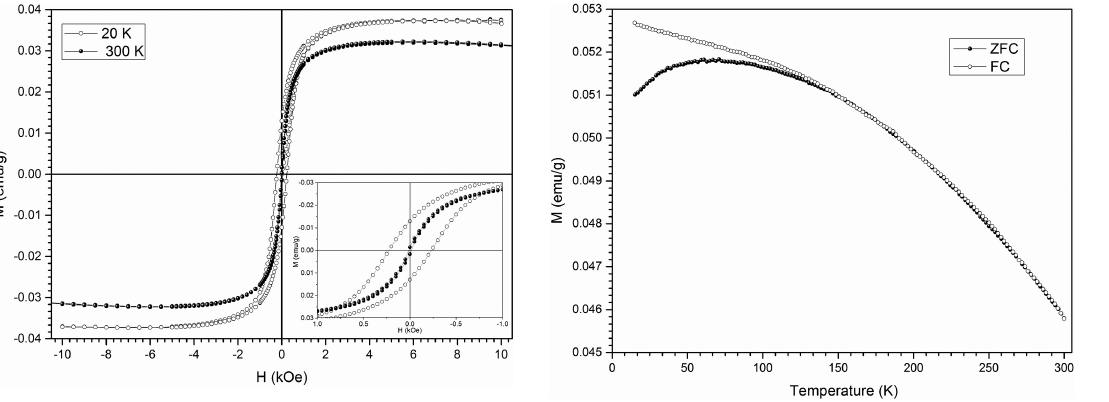
Figure 6. Superconducting quantum unit interference device (SQUID) measurement of Mag-PLGA recorded at 2 kOe showing divergence of magnetization curves corresponding to zero field cooled (ZFC, shown in black) and field cooled (FC, shown in white) plots, indicating